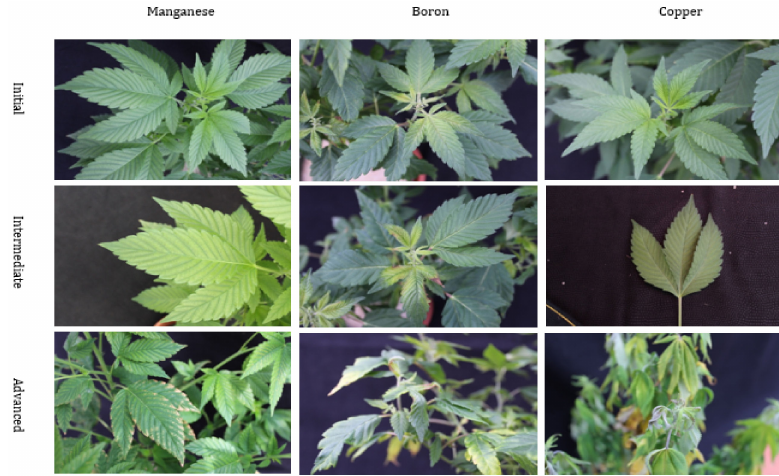
Figure 4. Nutritional disorders of manganese (Mn), boron (B), and copper (Cu) deficiency in Cannabis sativa ‘T1’ plants. These pictures display the symptomological progression of nutritional orders as they progress from initial, intermediate, and